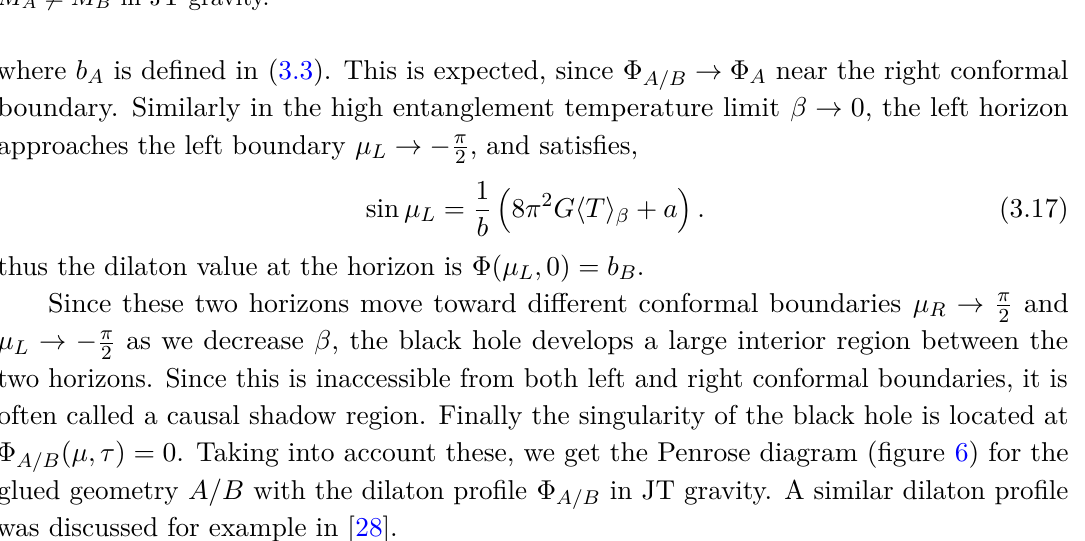
Figure 6 . The Penrose diagram of the glued spacetime A/B with two distinct black hole masses M A 6 = M B in JT